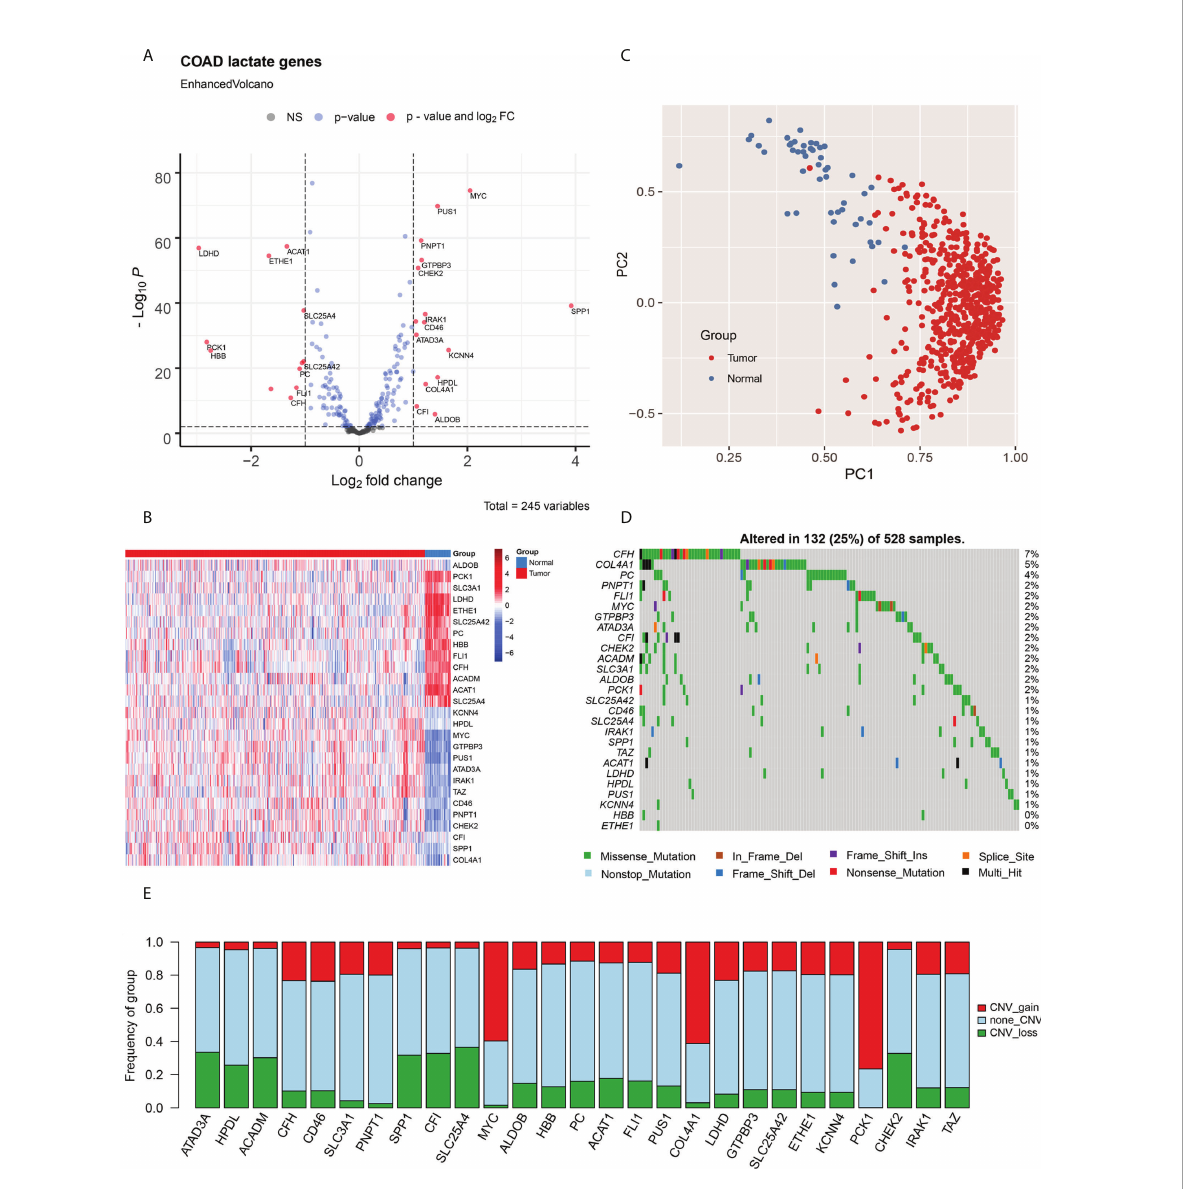
FIGURE 1 Identi fi cation of lactate-related genes in COAD and their genomic characteristics. (A) Volcano plot for analysis of differentially expressed genes in COAD; lactate-related genes with fold change > 2 and P < 0.01 are labeled in red. (B) Heat map of the lactate-related genes in COAD; the expression of genes are normalized. (C) The PCA, based on lactate-related genes, indicate that tumor samples and adjacent tissues are well- separated by fi rst principal component (PC1) and second principal component (PC2). (D) Statistical analysis of mutational frequencies of lactate- related genes in COAD; only SNVs and InDels are included. (E) Statistical analysis of CNV types of lactate-related genes in COAD, including gain of CNV (red), loss of CNV (green), and no CNV (grey). NS, No Signi fi